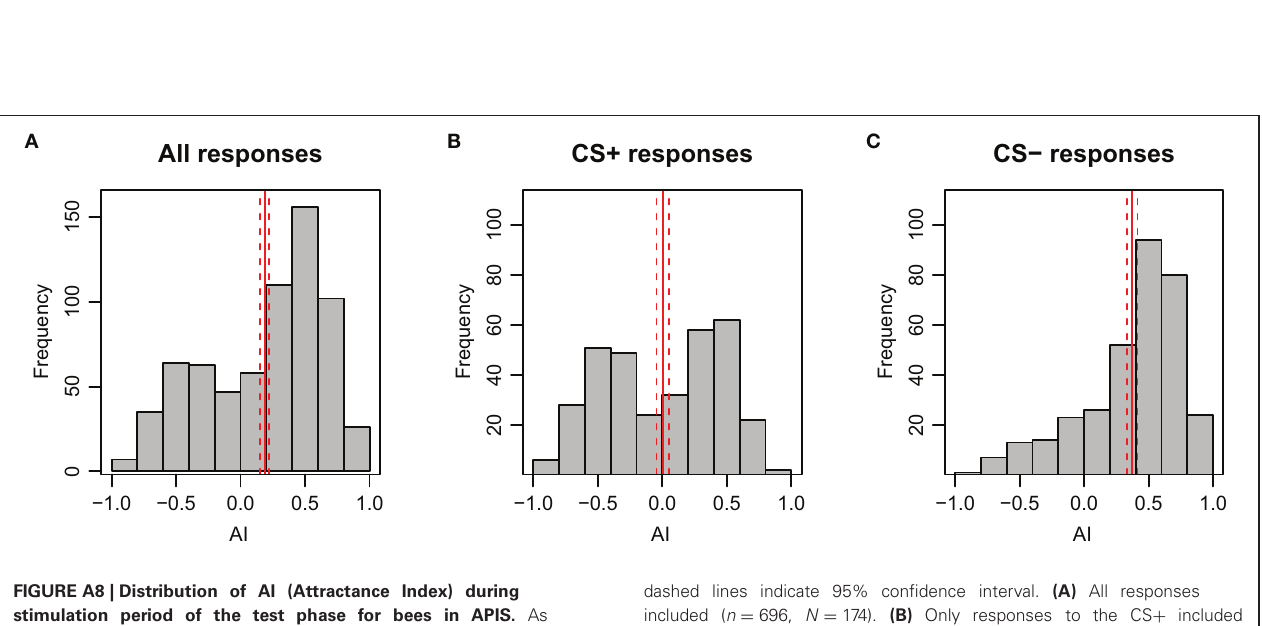
FIGURE A7 | Bees show a slight left preference in the conditioning chamber during test. The x-axis depicts the side preference, ranging from − 1 (complete left side preference) to 1 (complete right side preference), the y-axis the frequency with which the bees spent time at this side. Preference